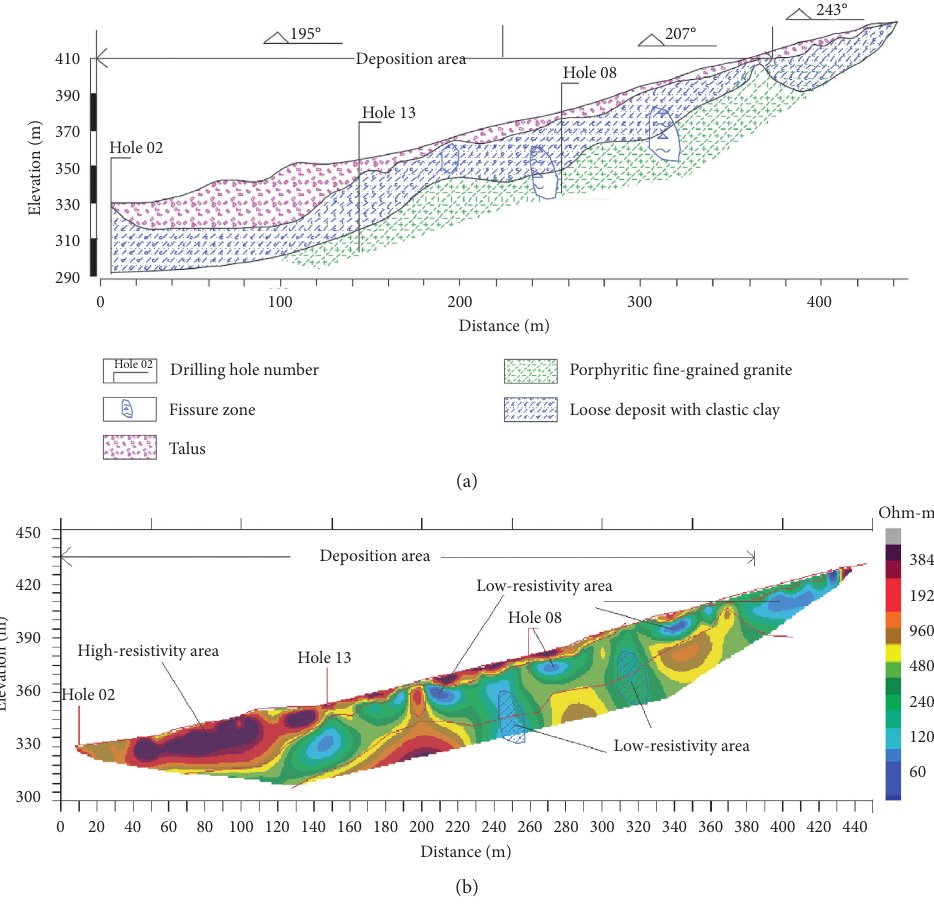
Figure 14: Borehole and HDERT results in the deposition area: (a) borehole profile and (b) HDERT image.